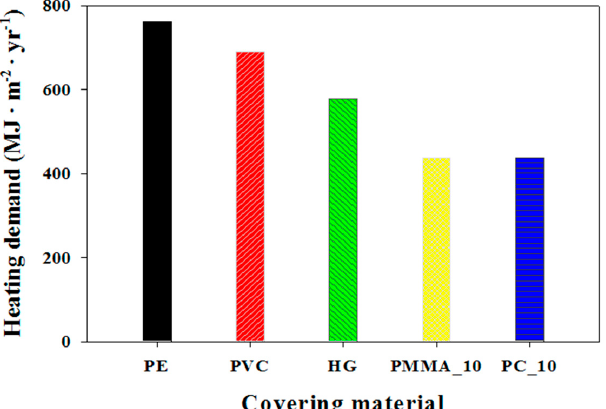
Figure 16. Annual heating demand of gothic ‐ shaped greenhouse by using different coverings. PE: Polyethylene, PVC: Polyvinyl chloride; HG: Horticulture glass; PMMA: Polymethylmethacrylate; PC: Polycarbonate.